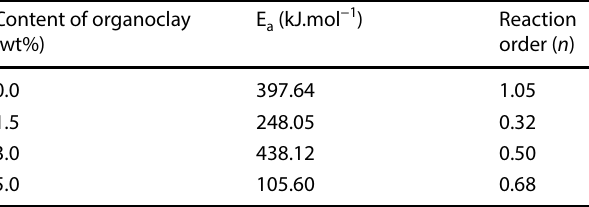
Table 3 Thermal decomposition parameters obtained by MLR method at 10 °C.min −1 for PP/MMT-IL nanocomposites